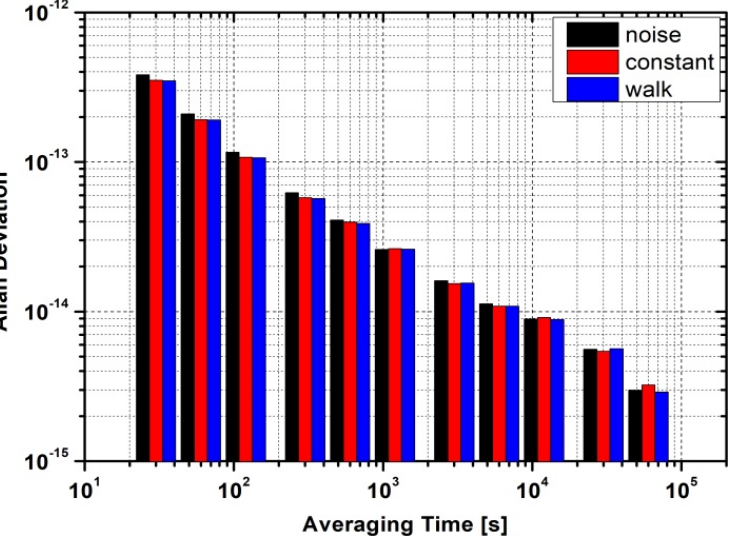
Figure 10. Comparison of Allan deviations in time-transfer results for the three ISB stochastic models at the PTBB–WTZZ time